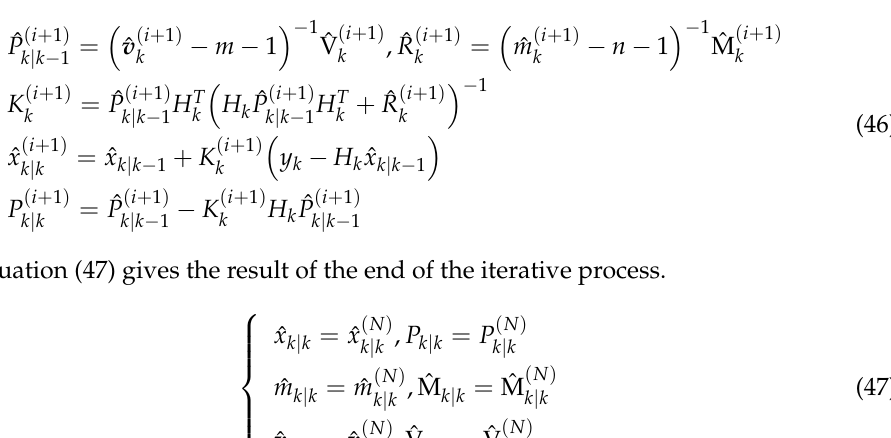
Next, update the approximate probability density function of the state by using the update expression of the approximate probability density function obtained before. The specific calculation process is shown in Equation (46).